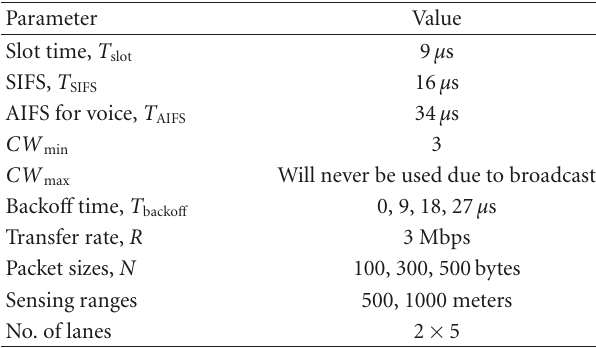
Table 2: Simulation parameters settings for CSMA and